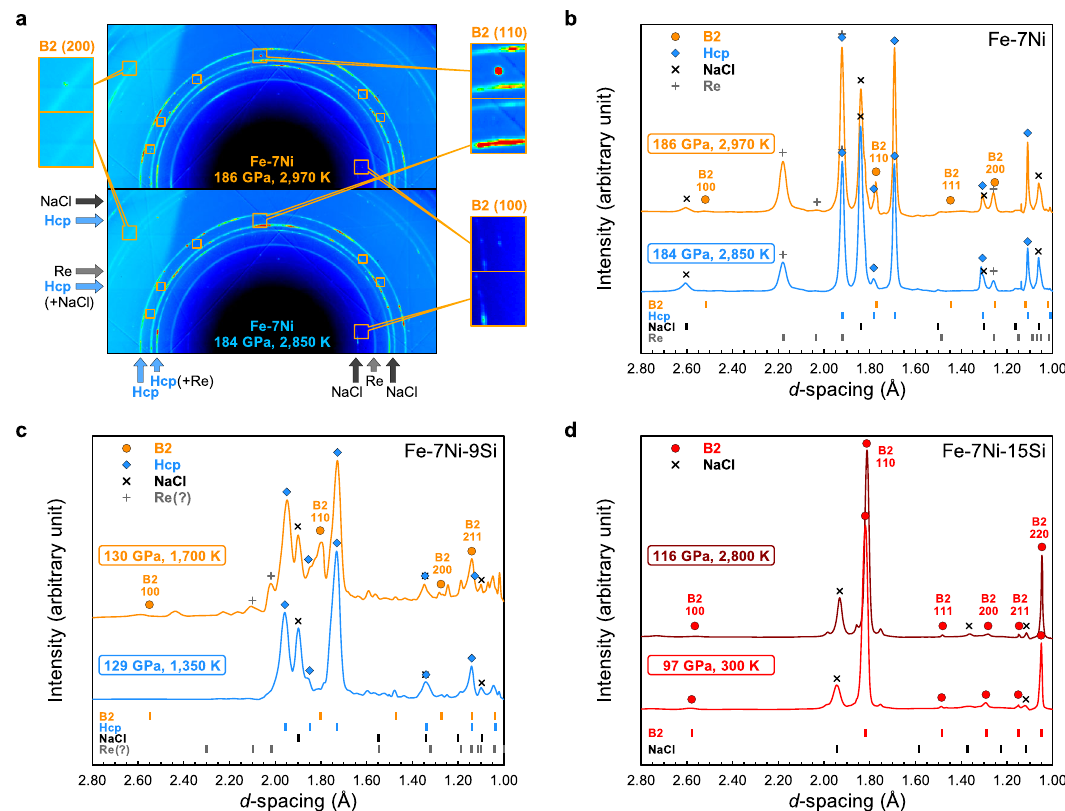
Fig. 1 Typical X-ray diffraction patterns of Fe – 7Ni, Fe – 7Ni – 9Si, and Fe – 7Ni – 15Si at high pressure and temperature. a Two-dimensional diffraction patterns collected at 184 GPa and 2850 K and 186 GPa and 2970K. Orange squares represent the appearance of typical peaks for the B2 phase of Fe – Ni. Blue and grey arrows indicate the diffraction of the hcp phase of Fe – Ni, sodium chloride (NaCl) and rhenium (Re). Integrated diffraction patterns of b Fe – 7Ni, c Fe – 7Ni – 9Si, and d Fe – 7Ni – 15Si. Orange circles: observed Fe – Ni peaks of the B2 phase in Fe – 7Ni and Fe – 7Ni – 9Si. Blue diamonds: observed peaks of the hcp phases in Fe – 7Ni and Fe – 7Ni – 9Si. Red circles in d : observed peaks of the single B2 phase in Fe – 7Ni – 15Si, ×: NaCl (B2 phase, as a pressure medium), + : Re (as a gasket). Bars at the bottom of the fi gures show the calculated peak positions for each